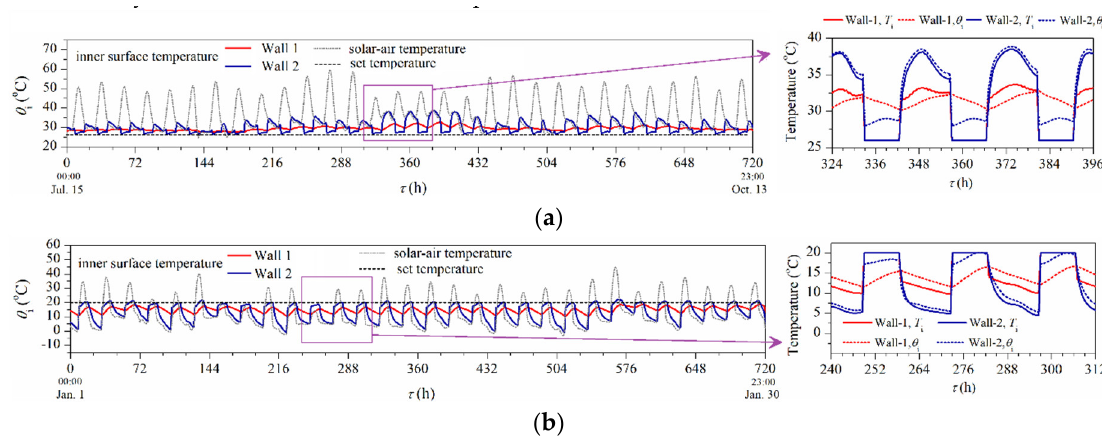
Figure 7. Variations of the inside surface temperature ( a ) in cooling season ( b ) in heating